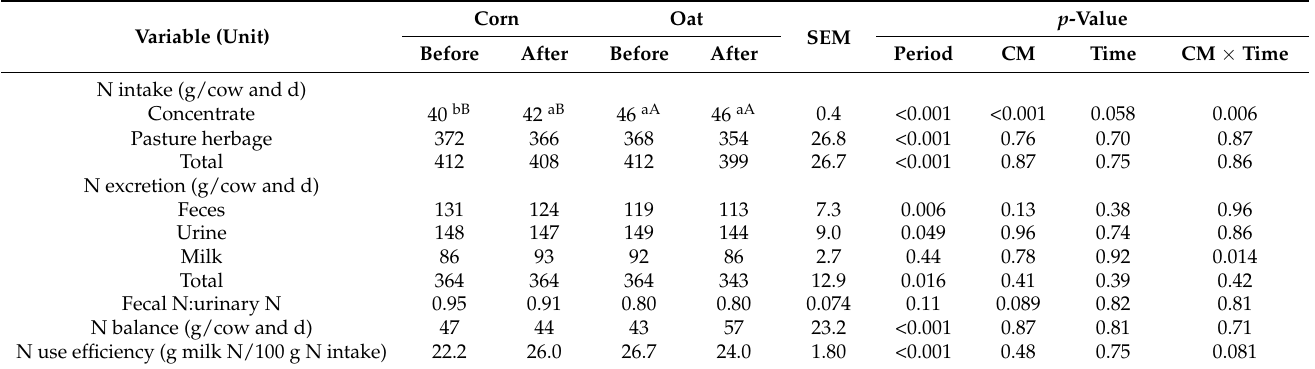
Table 6. Nitrogen (N) intake, excretion, and N use efficiency of lactating Brown Swiss cows grazing a mixed alfalfa-ryegrass sward and supplemented with a corn- or an oat-based concentrate mixture before or after grazing (least-squares means, standard errors of means (SEM); n =